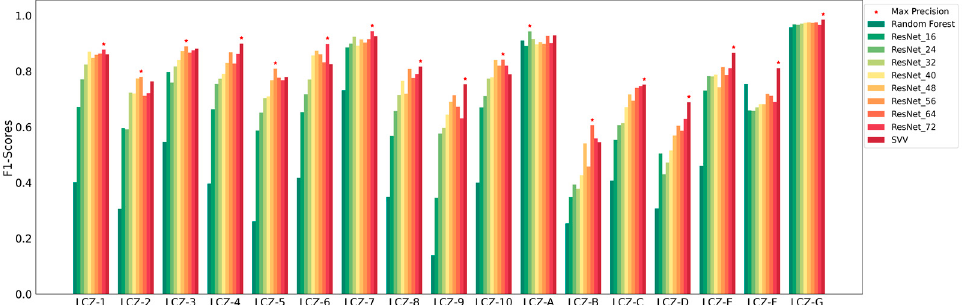
Figure 6. The partial results of three methods. ( a – d ) The LCZ maps around the Guangzhou Baiyun Airport: ( a ) original image, ( b ) Random Forest result, ( c ) ResNet result, and ( d ) SVS result. ( e – h ) LCZ maps of the Hongkong international Airport: ( e ) original image, ( f ) Random Forest result, ( g ) ResNet result, and ( h ) SVS result.